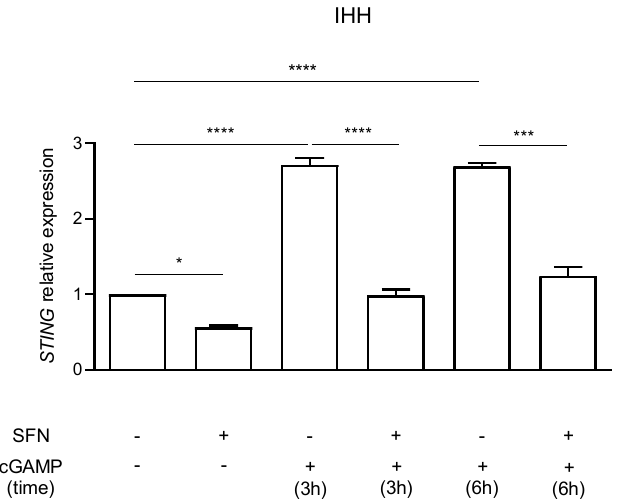
Figure 2. STING expression in IHH cells pretreated or not with sulforaphane (SFN, 10 µM) in pres- ence of inflammatory stimulus cGAMP (5.9 µM). Data are shown as means and C.I. of two repre- sentative experiments and reported evaluating 2 −ΔΔ Ct values using untreated cells as calibrator and HPRT1 and G6DP housekeeping genes as reference. *: p <0.05, one way ANOVA untreated CTRL IHH cells vs. 72 h SFN 10 µM treatment. ****: p < 0.0001, one way ANOVA IHH exposed to 5.9 µM cGAMP for 3 h and vs. IHH pre-treated with SFN 10 µM for 72 h and 5.9 µM cGAMP for 3 h. ***: p < 0.001, one way ANOVA IHH exposed to 5.9 µM cGAMP for 6 h vs. IHH pre-treated with SFN 10